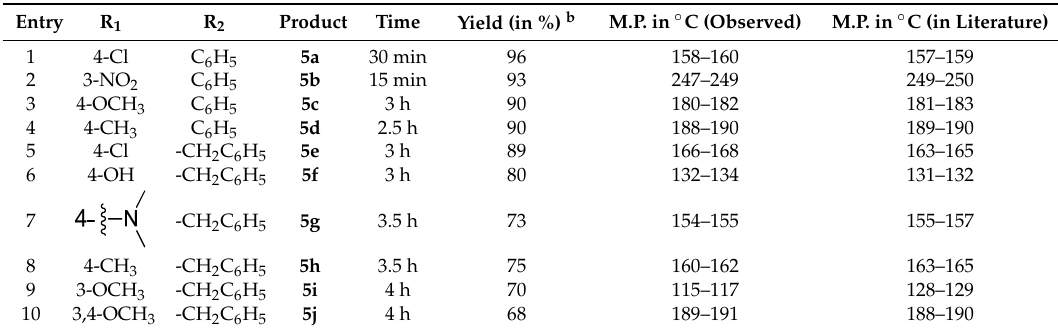
Table 3. Synthesis of various 1,2,4,5-tetrasubstituted imidazoles catalysed by β -CD-PSA under solvent free conditions a [20–24].